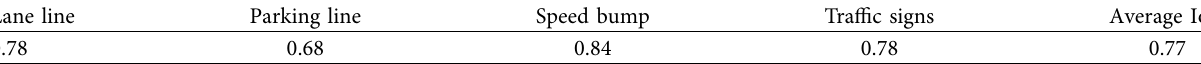
Table 1: The IoU result.